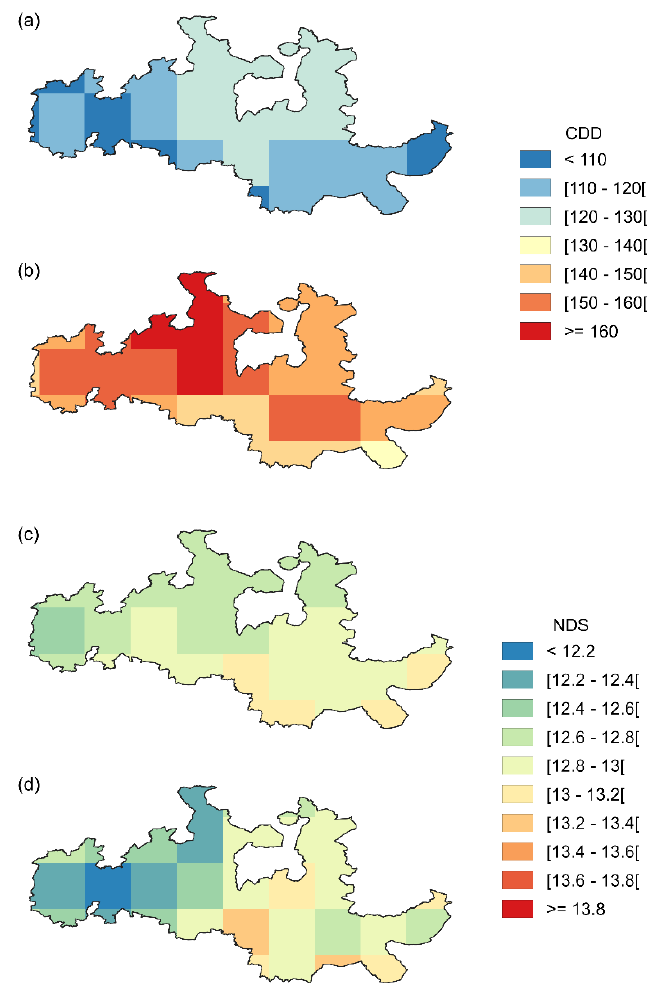
Figure 6. Ensemble-mean of the Consecutive Dry Days index (CDD) for the Douro Wine Region and the future period (2051–2080), under the RCP8.5, with a bias correction following the ( a ) linear and ( b ) quantile mapping methods. ( c , d ) The same as ( a , b ) but for the Number of Dry Spells (NDS).